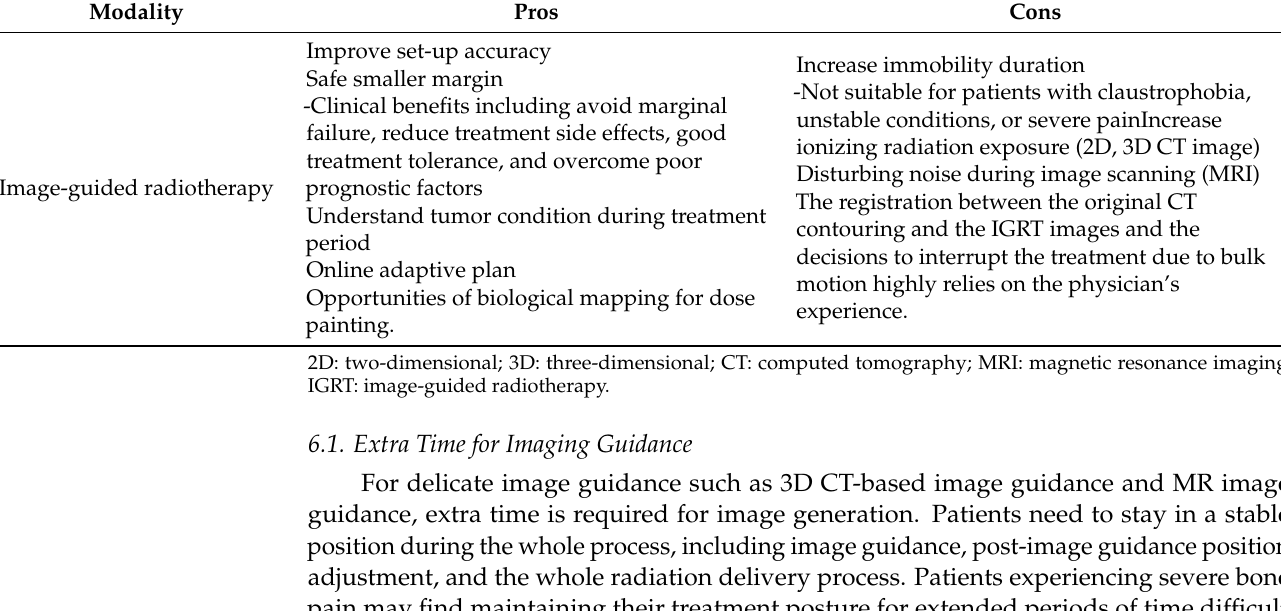
Table 5. The pros and cons for image-guided radiotherapy for patients with oral cavity